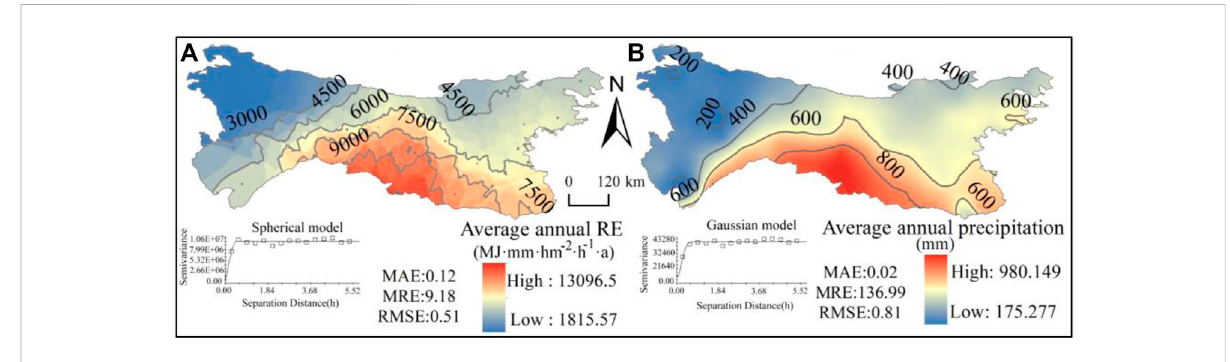
FIGURE 5 Spatial distribution of AARE (A) and AAR (B) in Qinba